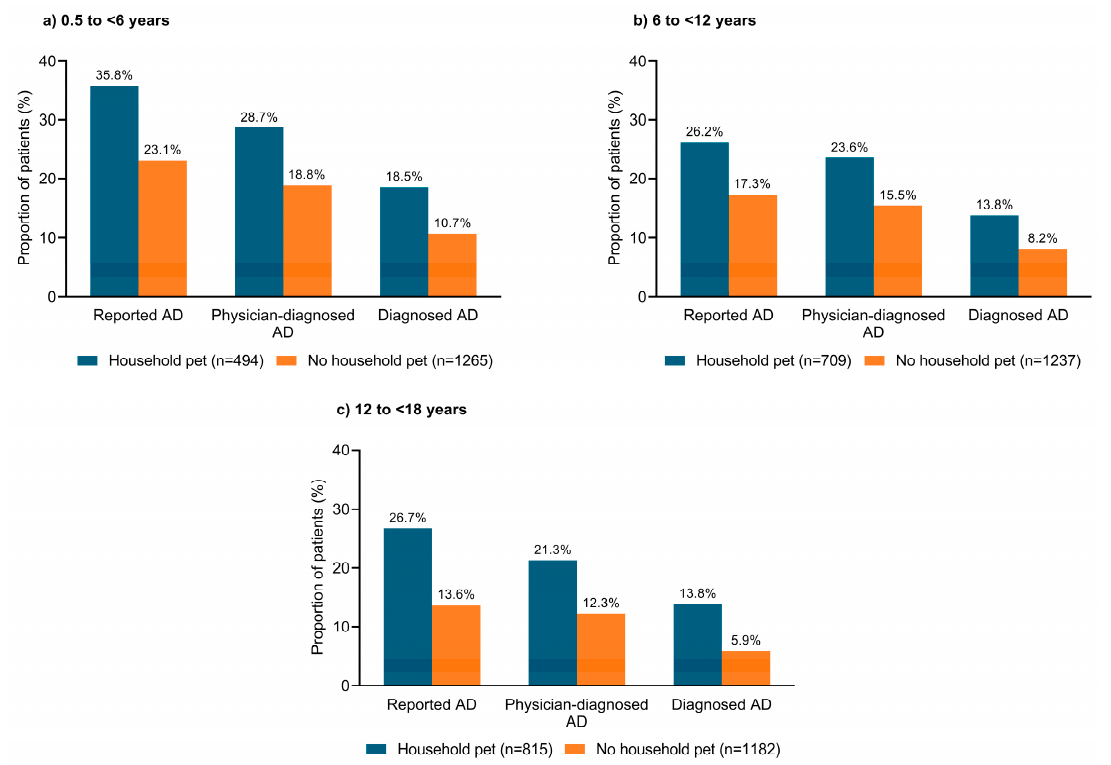
Figure 5. Prevalence of atopic dermatitis according to the presence of a household pet in Japanese pediatric patients aged ( a ) 0.5 to <6 years; ( b ) 6 to <12 years; ( c ) 12 to <18 years. AD, atopic dermatitis.